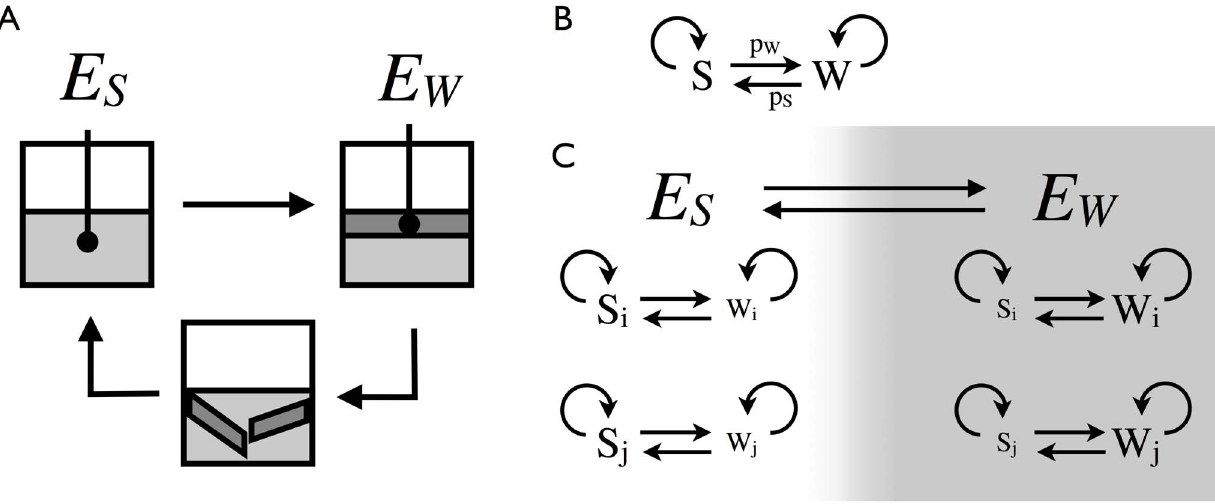
Figure 1. Model schematics. (A) The upper left ( E S ) represents initial growth in an oxygen rich broth that favors the smooth S phenotype. As organisms grow and divide, they consume oxygen and eventually the air-liquid interface is the only place with available oxygen. This environment ( E W ) selects for the wrinkly W phenotype because it forms a mat at the air-liquid interface through production of a cell-to-cell glue. The mat grows and ultimately collapses under its weight, causing oxygen to flood back into the broth. This, in a sense, returns the system to its starting point. (B) SW organisms are modeled as stochastic switchers whose one genotype is capable of giving rise to either an S type or a W type at division. The S type produces a W type with probability p w and the W type produces an S type with probability p s . (C) Two organisms SW i and SW j compete in environments E S and E W . Each organism stochastically switches between S and W phenotypes which are suited to environments E S and E W , respectively. The environments switch when the total population reaches a fixed value, the carrying capacity N , analogous to the amount of oxygen in the broth or maximum weight supported by a mat.